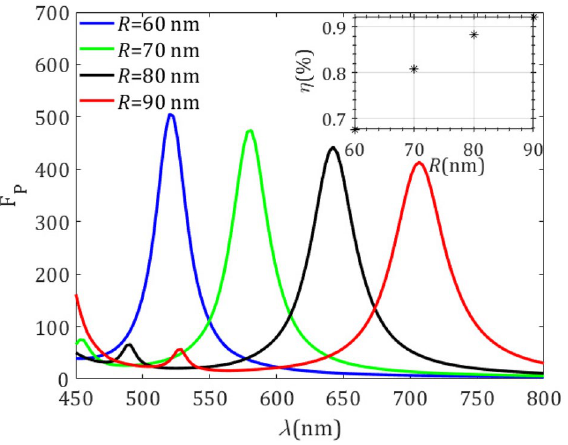
Figure 4. Purcell factor F P for different radii R of the silicon spherical resonator. The fixed geometrical 10 nm and α 30 ◦ as in Figs. 2 and 3. Inset: quantum efficiency η versus R at peak parameters are d = = frequencies.